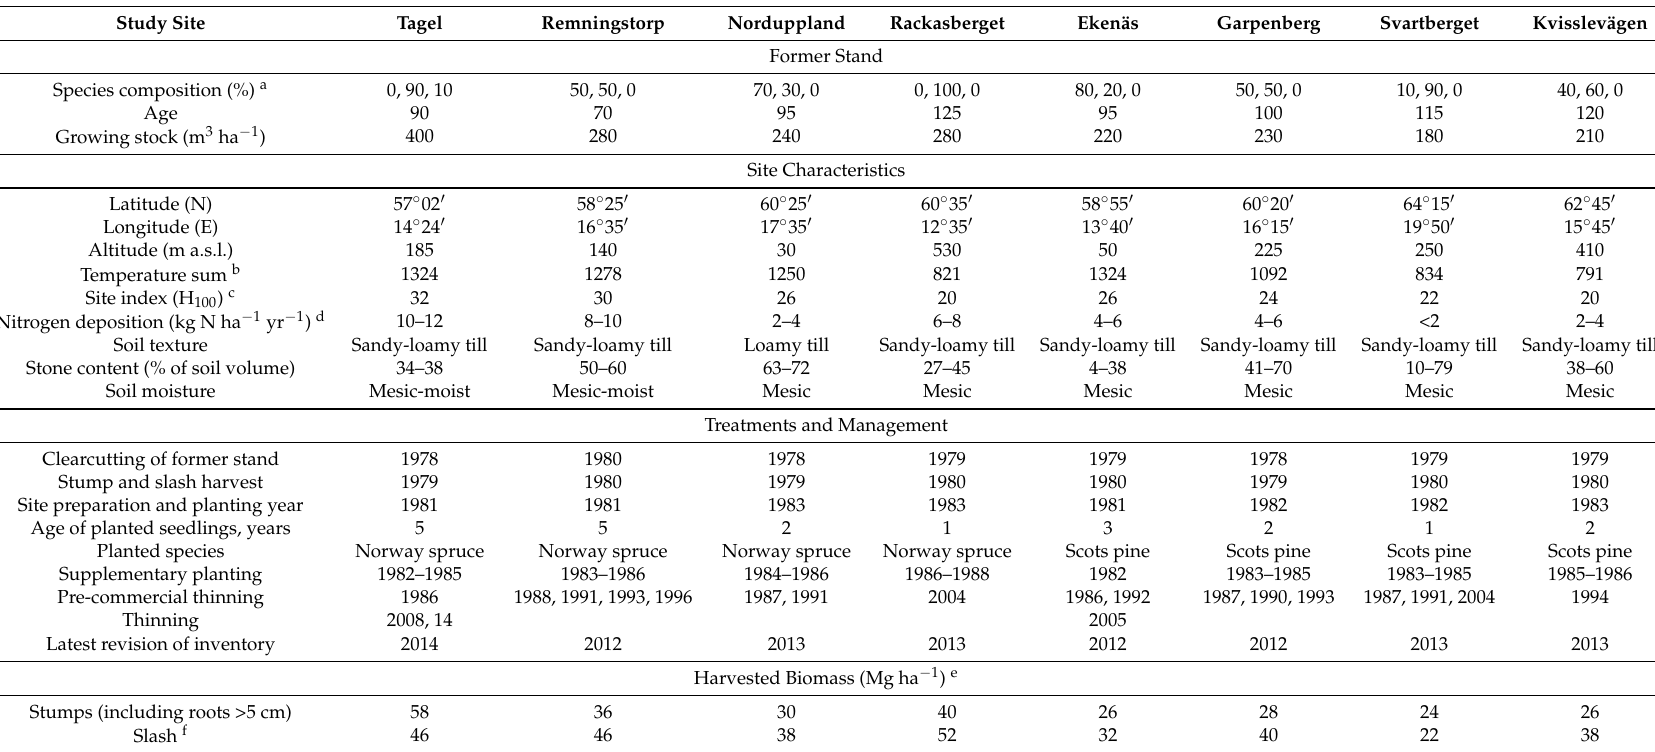
Table 1. Location and characteristics of the experimental sites and information about the former stand and the new stand including silvicultural measures applied over the study period according to